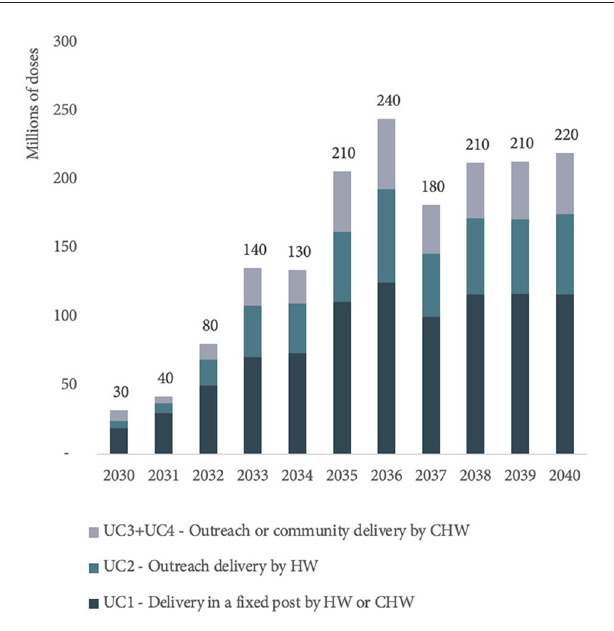
FIGURE5 Estimated global PDR for MR-MAPs from 2030 to 2040 by use case. PDR, programmatic doses required; MR, measles and rubella; MAPs, microarray patches; UC, use case; HW, health worker; and CHW, community health